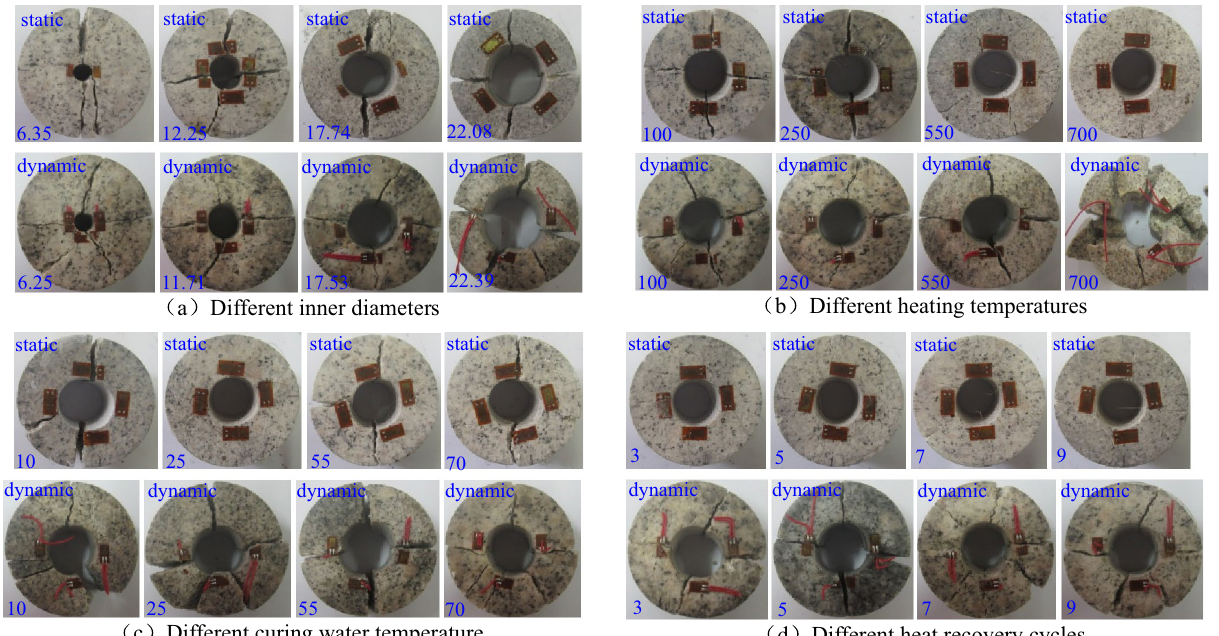
Figure 6. The final failure state of circular granite under radial compression (The figures in ( a ) represent the inner diameter of the circular granite samples, and their units are mm. The figures in ( b ) represent the high temperature at which the circular granite samples were processed, and their units are °C. The figures in ( c ) represent the water temperature for curing the circular granite samples, and their units are °C. The figures in ( d ) represent the cycle heat recovery times of circular granite samples, and their units are time. The inner diameter of the rock samples are all about 18 mm in ( b – d